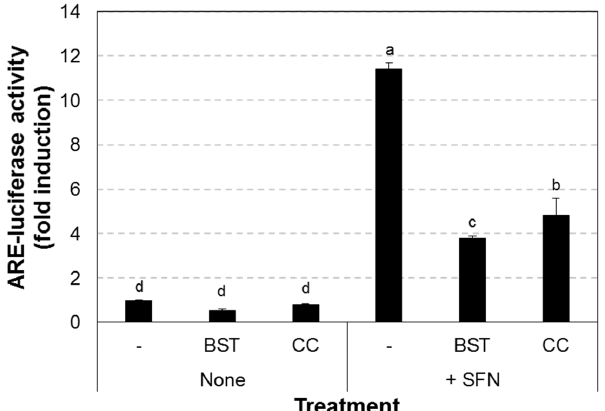
Figure 2. Chestnut leaf extract reduced antioxidant response element (ARE)-luciferase activity. HepG2-ARE cells were plated in a 6-well culture plate and treated with the indicated agents for 4 h. CC, Castanea crenata leaf extract, 50 μ g/mL; SFN, sulforaphane, an ARE activator, 5 μ M; BST, Brusatol, an Nrf2 inhibitor, 40 nM. N = 3; error bars, mean ± SEM. Values not sharing common letter on bar indicate statistically significant difference from each other ( p < 0.05).